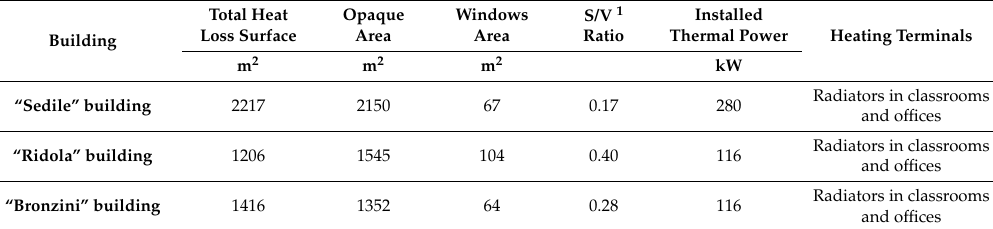
Table 2. Technical characteristics of the case